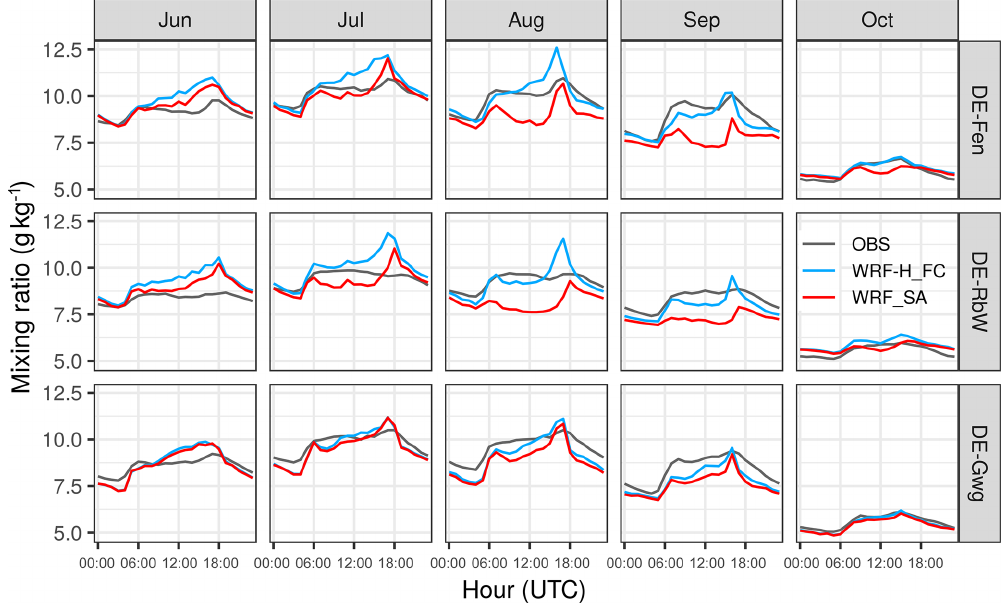
Figure 10. Mean diurnal cycles of simulated and observed 2m mixing ratio for the months June to October 2016 at different TERENO Pre-Alpine Observatory sites.